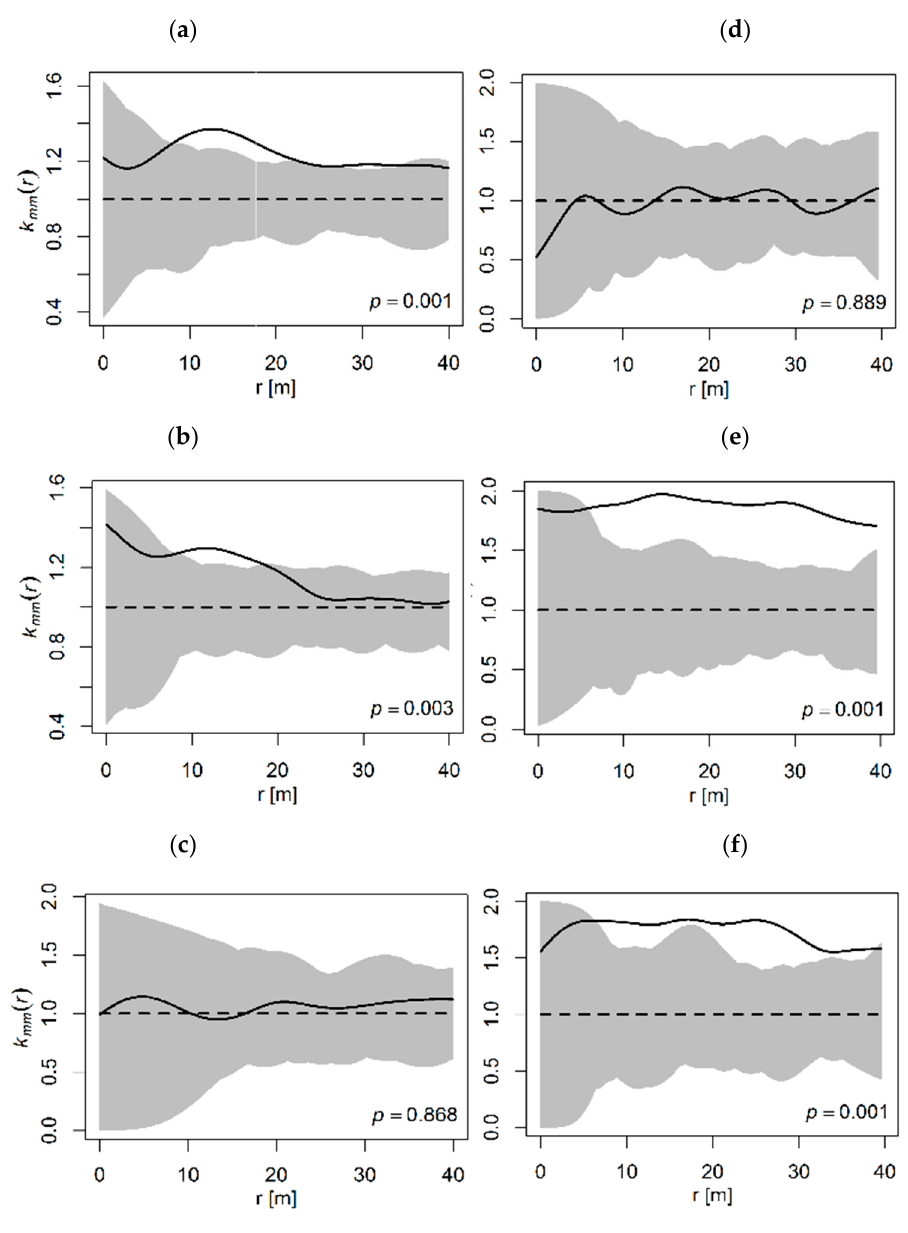
Figure 5. Multitude of size classes at distance r (mark correlation kmm(r)). The solid line shows observed kmm(r) values, the dashed line denotes the CSR and the gray area represents the confidence envelope. ( a , d ): Intermediate–Sapling, ( b , e ): Adult–Sapling, ( c , f ): Adult–Intermediate.